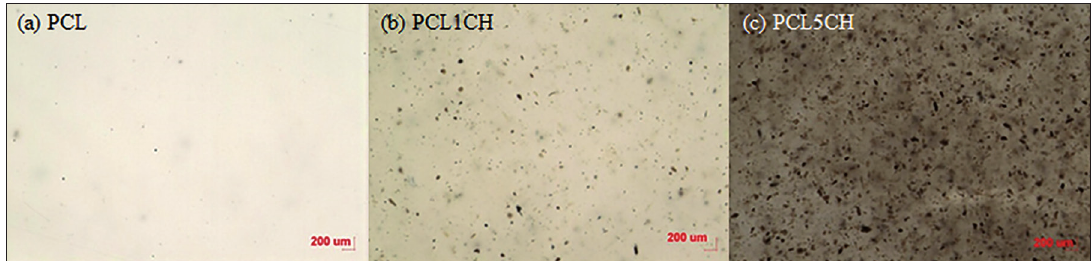
Figure 1: Photographs of films: (a) PCL, (b) PCL1CH and (c)